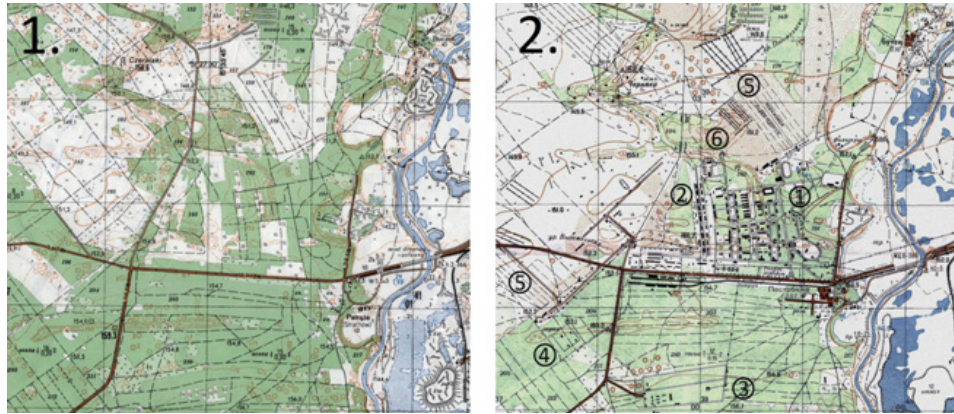
Fig. 6. The method of camouflaging the Pstrąże (Strachów) garrison on maps 1:25,000 (sheet M-33-20-C-a Leszno Górne): 1) the “First Edition of the Polish People’s Republic” map, 1967, 2) the Soviet map,